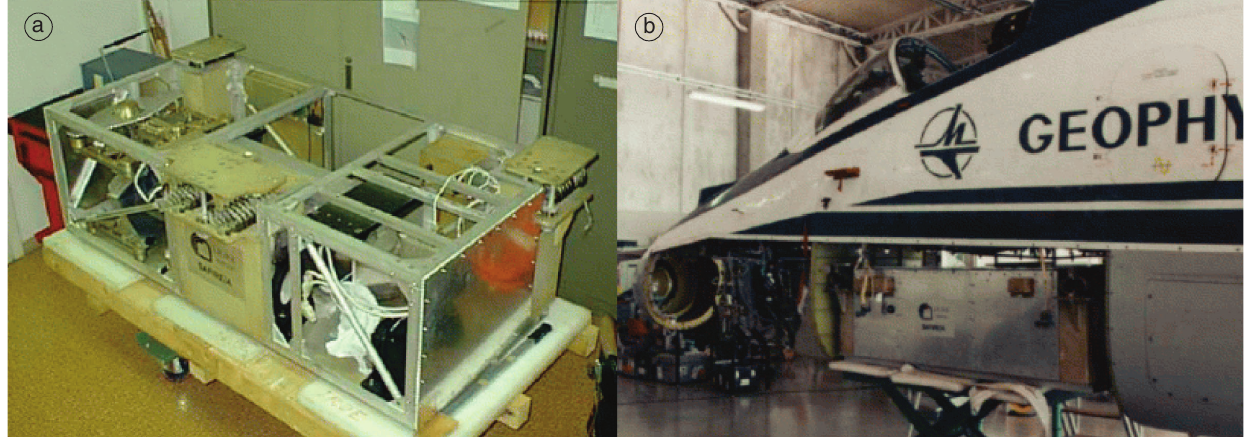
Fig. 9a,b. Photographs of the SAFIRE-A instrument: a) instrument ready for laboratory operations; b) instrument installed on the M-55 Geophysica.